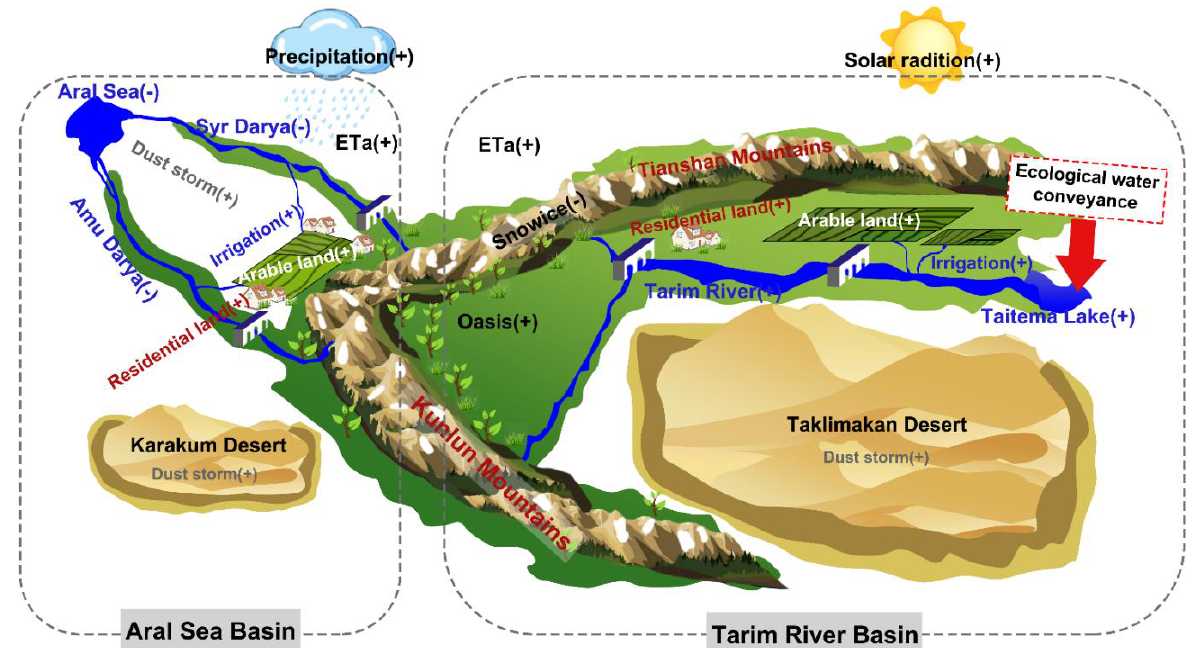
Figure 7. Schematic diagram summarizing the response of water resources to climate change in the Aral Sea Basin and the Tarim River Basin, Central Asia. For each factor impacting the water resource, the corresponding symbols “+” and “−” in brackets represent an increasing trend and a decreasing trend, respectively, in response to climate change.